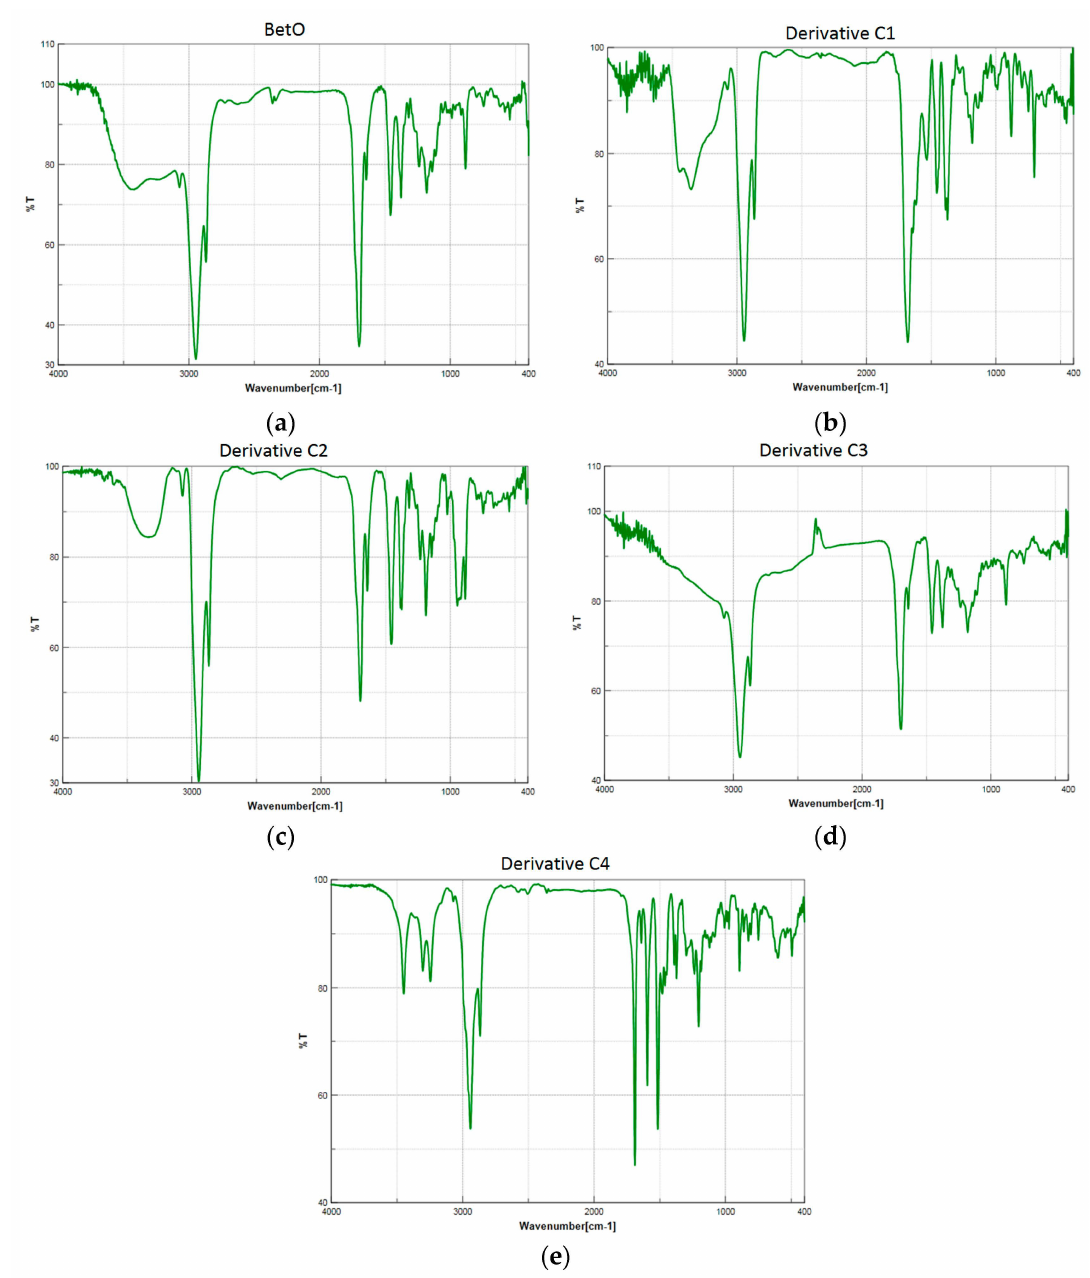
Figure 2. FTIR spectra of the analyzed compounds: ( a ) starting material BetO; ( b ) derivative C1 ; ( c ) derivative C2 ; ( d ) derivative C3 ; ( e ) derivative C4